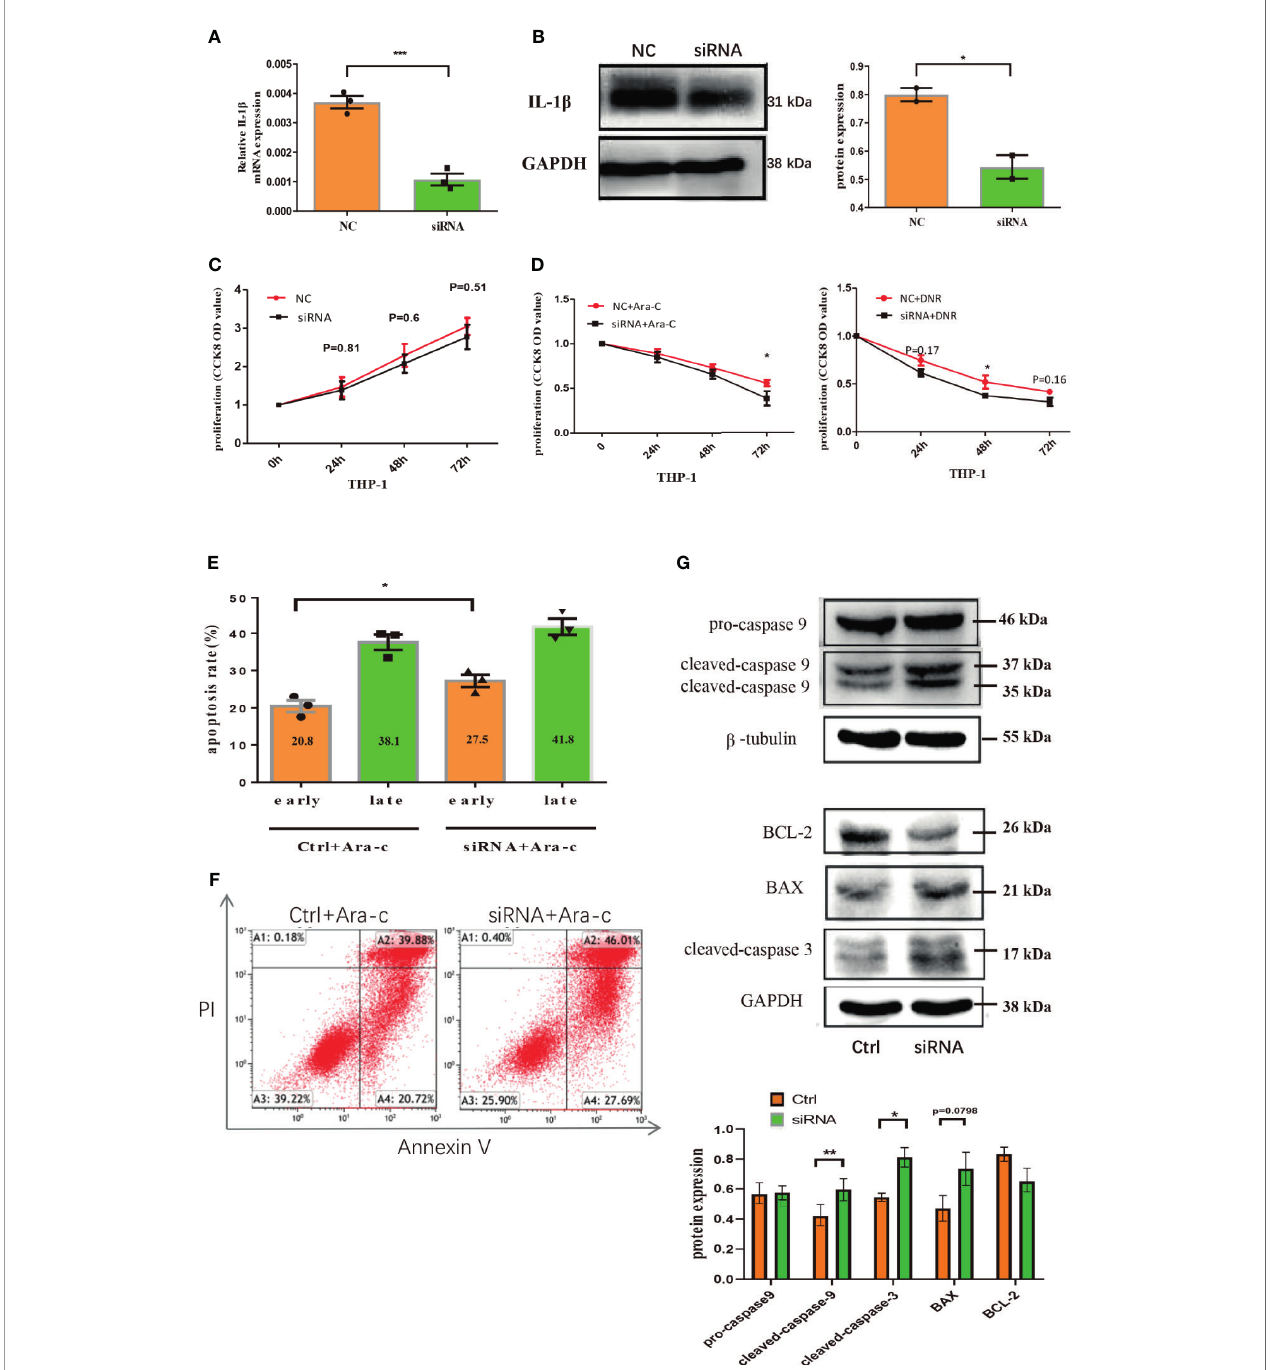
FIGURE 6 | Down-regulation of endogenous IL-1 b suppresses the growth of leukemia cells. The mRNA expression of IL-1 b was determined by qRT-PCR in THP1 cells after IL-1 b siRNA transfection (n=3) (A) and the protein level of IL-1 b by western blot in THP1 cells after IL-1 b siRNA transfection was also shown (n=3) (B) . The proliferation results by CCK8 assay for leukemia cells 24, 48, 72 hours after knocking down IL-1 b by siRNA transfection (n=3) (C) and treatment with drugs (n=3) (D) . The apoptosis of THP1 cells was quanti fi ed 48 hours after IL-1 b knockdown by siRNA (n=3) (E) and the representative scatter plots of apoptosis (F) . (G) The western blot results of pro-caspase-9, cleaved caspase-9, and b -tubulin is a loading control. Representative western blot bands of Bcl-2, BAX, cleaved caspase-3, and GAPDH is a loading control (n=3). *P < 0.05; **P < 0.01; ***P <